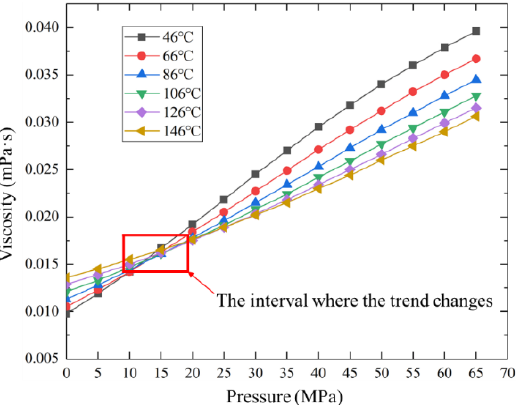
Figure 9. Gas viscosity under different temperatures and pressures.